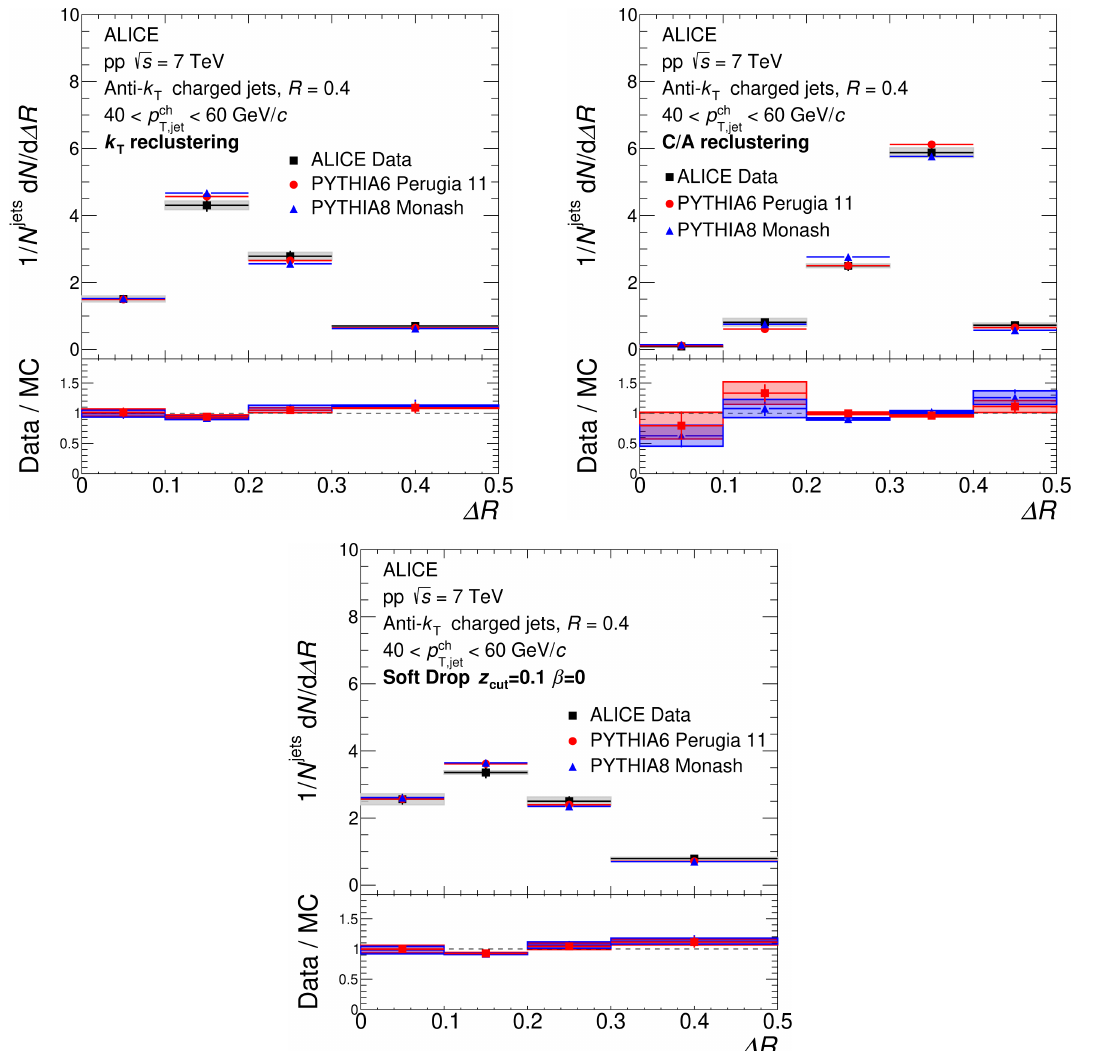
Figure 5 . Fully corrected ∆ R distributions, measured with the k T , C/A and C/A with Soft Drop √ grooming algorithms, in pp collisions at interval s = 7 TeV for jets with R = 0 . 4 in the jet p ch T , jet of 40 – 60 GeV /c , are shown. The systematic uncertainties are given by the grey boxes. The results are compared with PYTHIA6 Perugia 2011 and PYTHIA8 Monash. The uncertainties presented for the PYTHIA distributions are purely